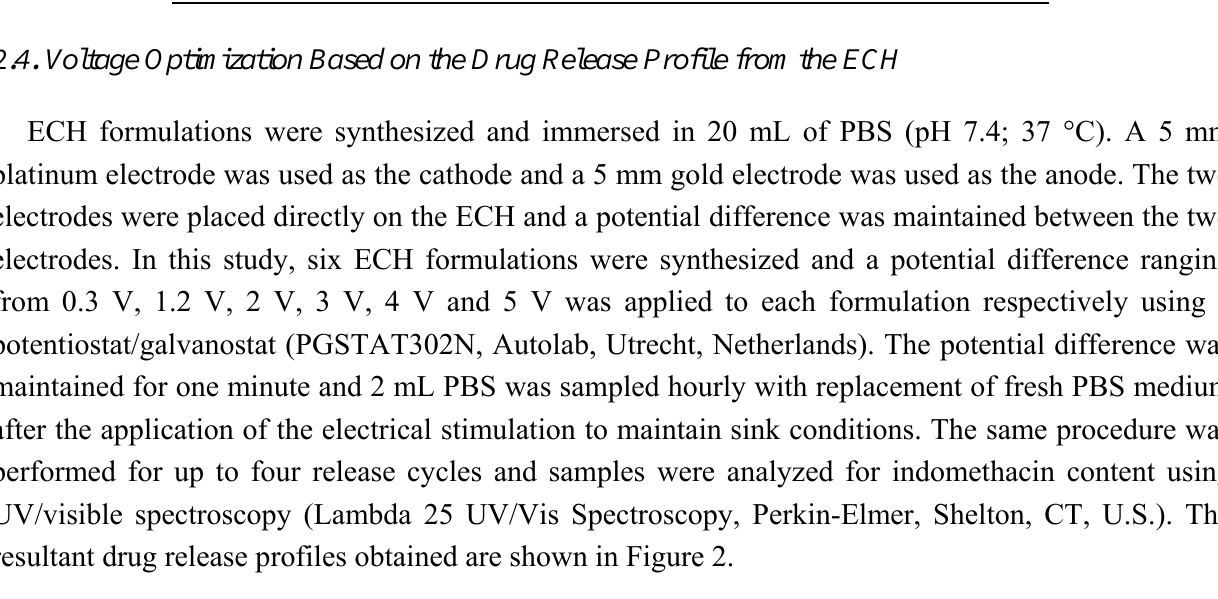
Figure 2. Drug release profiles showing the influence of various potential differences on the